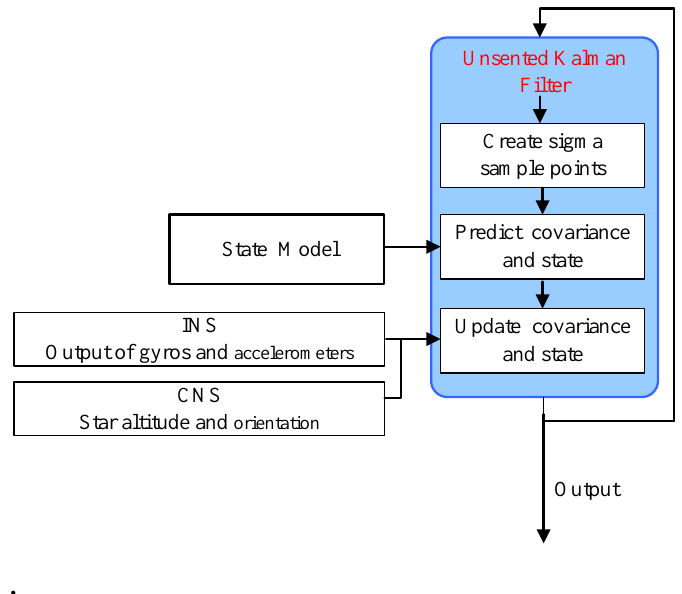
Figure 3. Celestial assisted INS initialization algorithm.